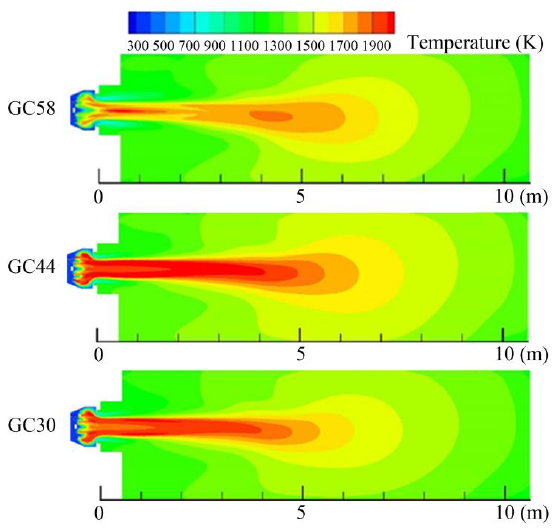
Figure 8. The distribution of Temperature for GC58, GC44 and GC30 at z = 0.